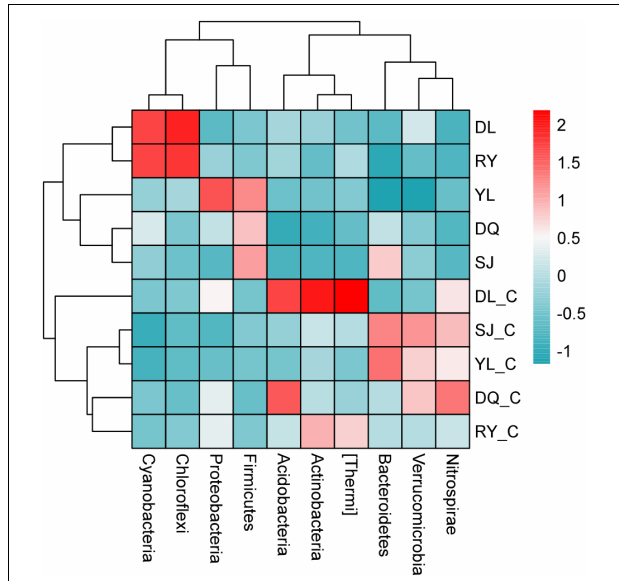
FIGURE 5 | Cluster analysis of microbial populations in different bio-eroded shells. DL, DQ, RY, SJ, and YL represent the microbial communities of bio-eroded shells from five different geographical locations, respectively. DL_C, DQ_C, RY_C, SJ_C, and YL_C represent the microbial communities of the healthy snails shells from five different geographical locations, respectively. SL, Sanjiang County; YL, Yongle Town; DL, Dongliang Village; DQ, Dongquan Town; RY, Renyi Village.